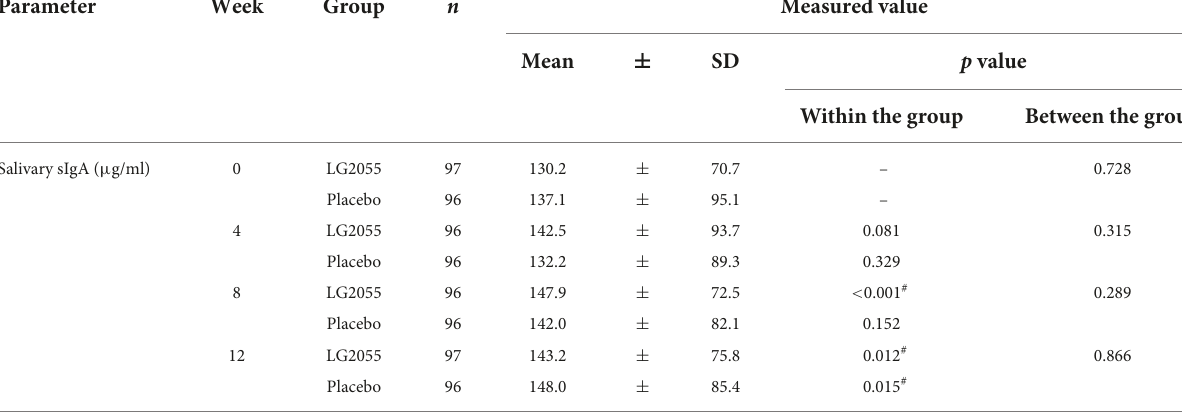
TABLE 4 Measured values of the concentration of salivary sIgA during the intake period. Parameter Week Group n Measured value